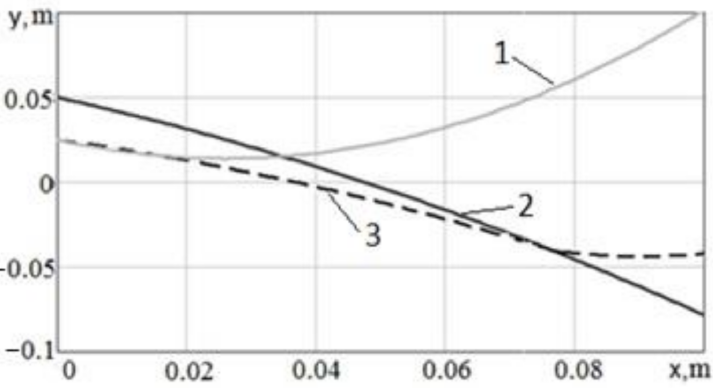
Figure 6. The trajectories of impurity particles in the vertical duct (d p = 0.001 m; ρ p = 600 kg · m − 3 ): 1—trajectories of impurity; 2—the upper boundary of the grain layer; 3—the impurity trajectory without considering the effect of the grain layer.